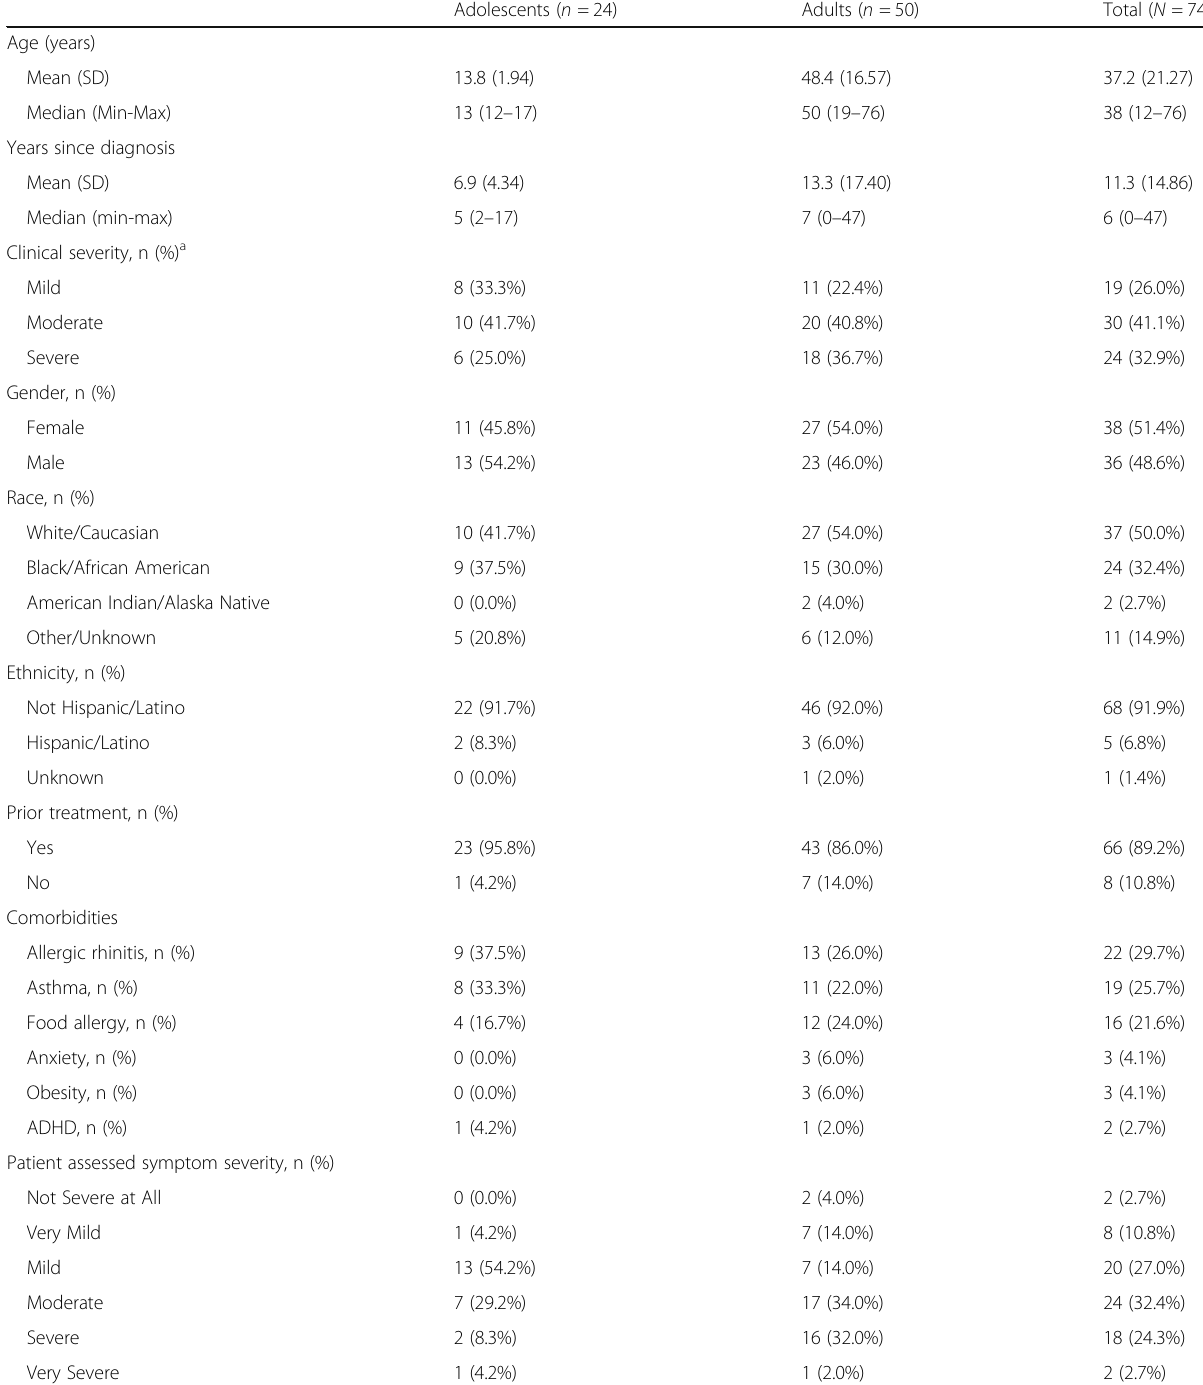
Table 1 Demographic and Clinical Data for the N = 74 Total Study Population